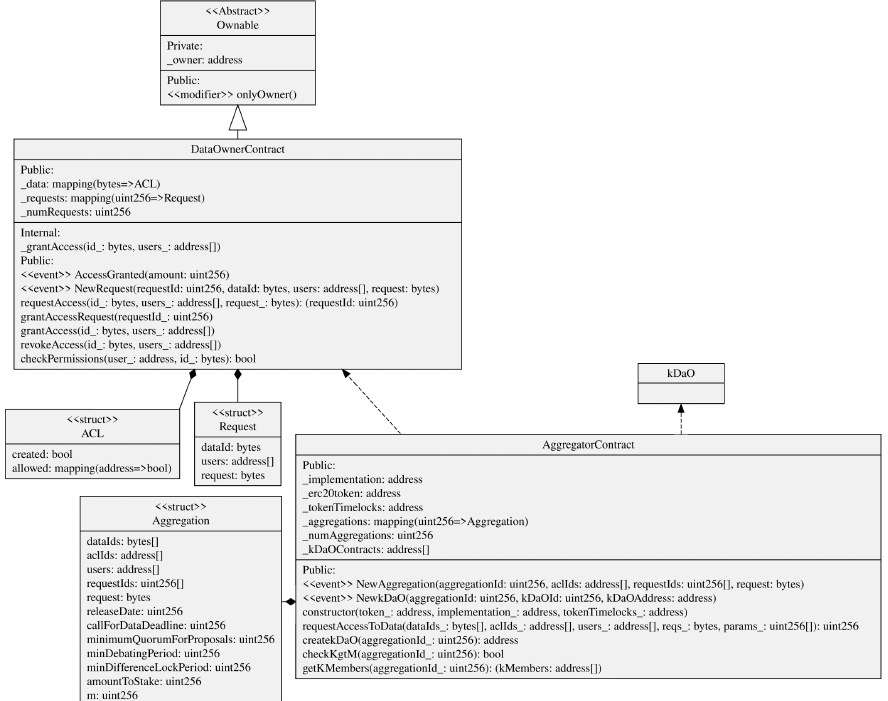
Figure 6. UML Class Diagram of DataOwnerContract and AggregationContract . Some classes, attributes and methods have been removed to render the diagram